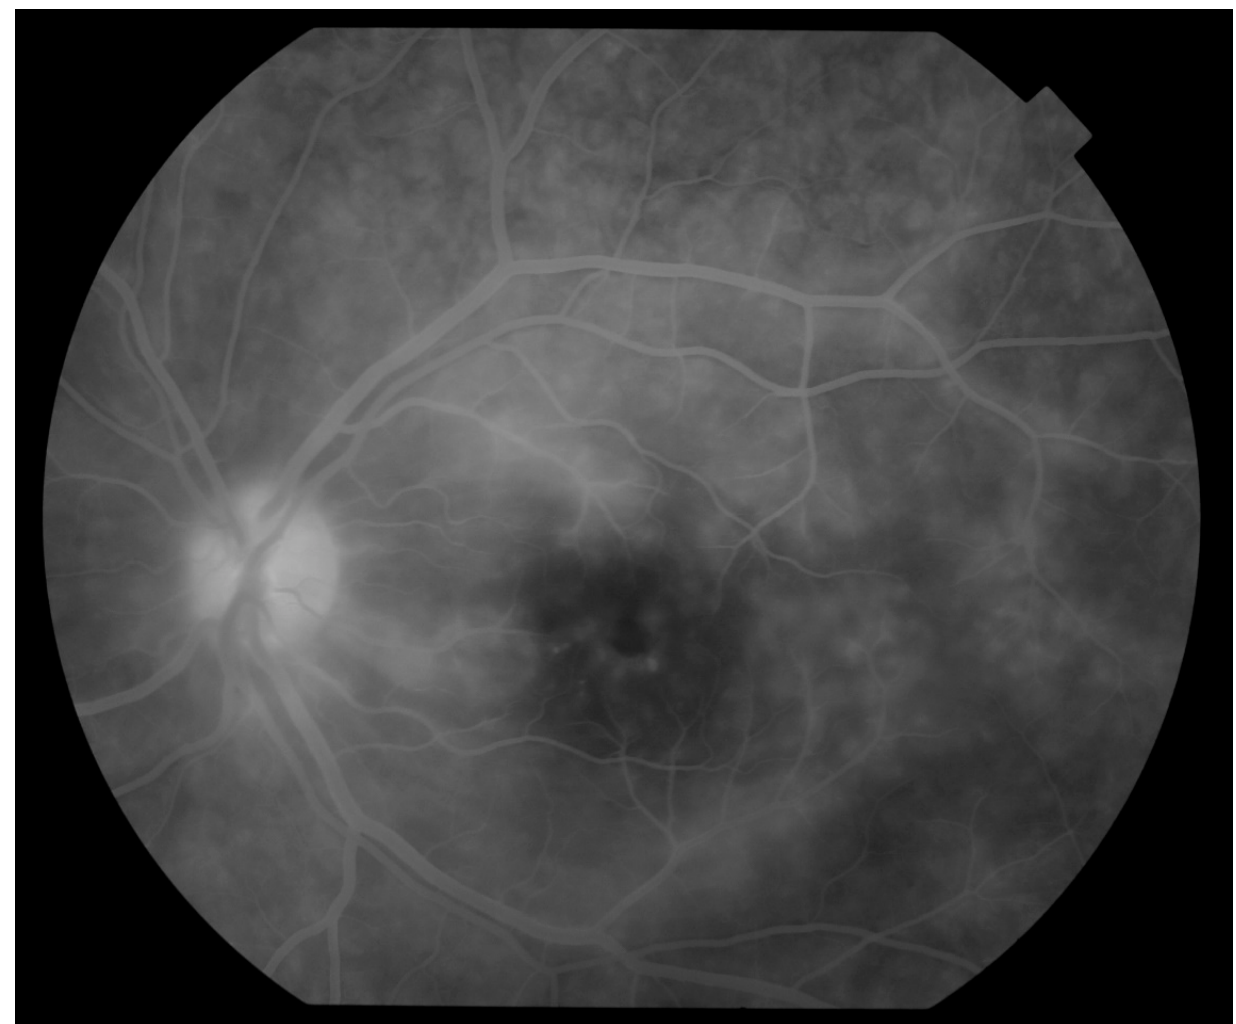
Figure 2. Fluorescein angiography of a patient with Behçet’s uveitis with cystoid macular edema, venous leakage, leakage from the cilioretinal artery and optic disc edema.